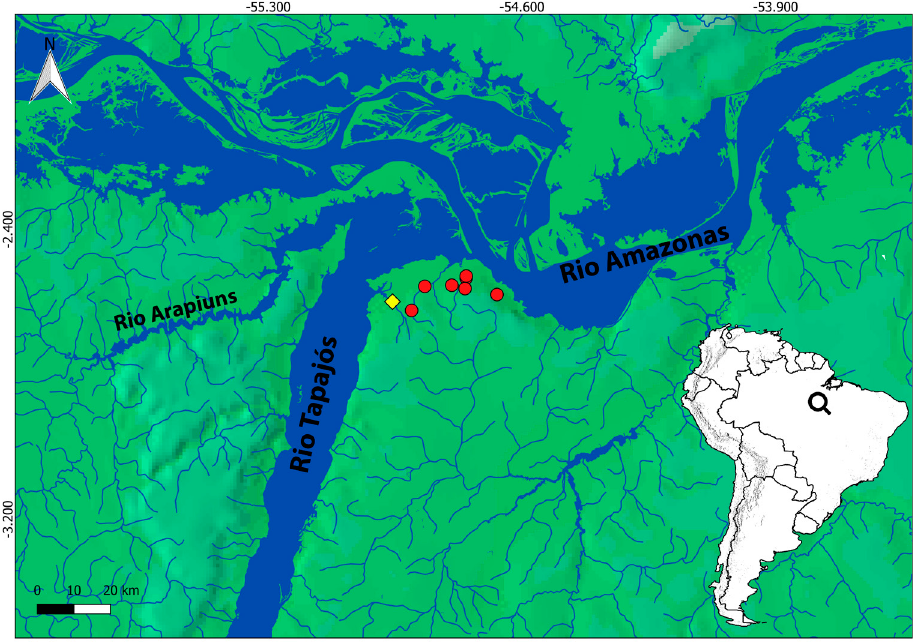
FIGURE 3 | Map of the lower rio Tapajós and its confluence with the rio Amazonas, showing the known distribution of Hyphessobrycon cantoi (red circles indicate paratypes localities; yellow diamond indicates type